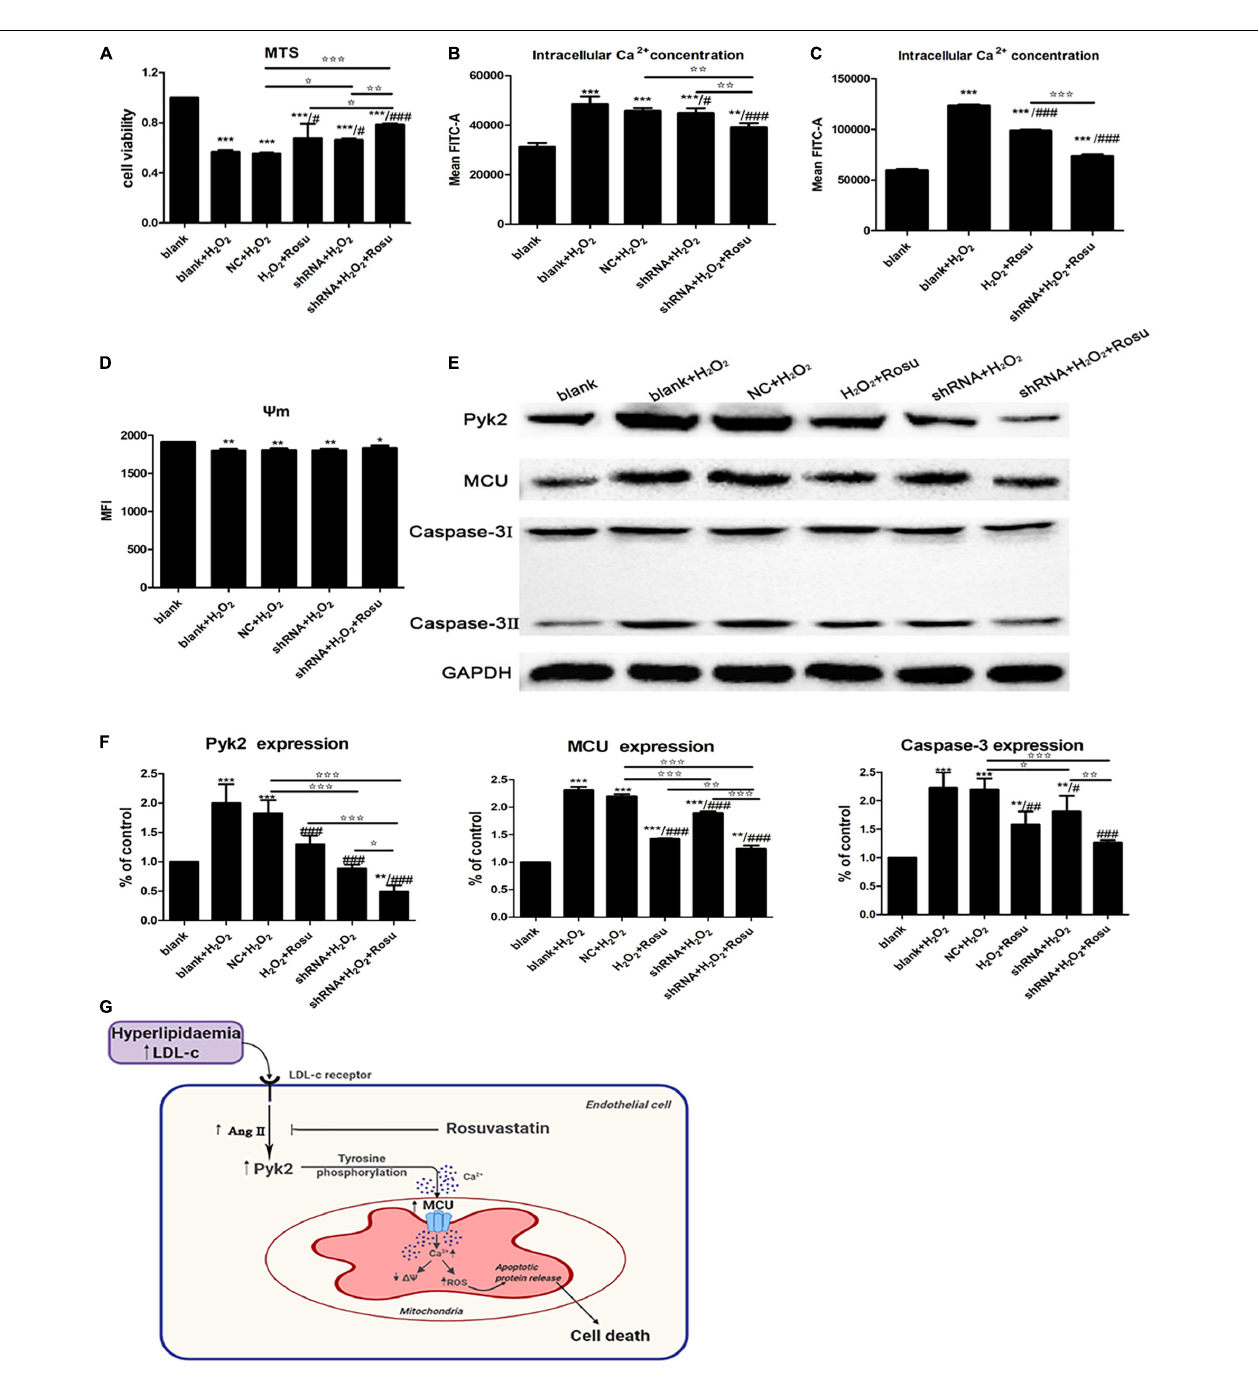
FIGURE 8 | The effect of Pyk2 down-regulation on H 2 O 2 -induced human umbilical vein endothelial cells (HUVECs) injury and regulation of the Pyk2/mitochondrial calcium uniporter (MCU) pathway in endothelial cell. (A) Detection of cell viability by 3-(4,5-dimethylthiazol-2-yl)-5-(3-carboxymethoxyphenyl)-2-(4-sulfophenyl)- 2H-tetrazolium assay after transfection with shRNA. (B–D) Detection of intracellular free Ca 2 + and mitochondrial membrane potential in different groups by flow cytometry. (E) Pyk2, MCU, and caspase-3 protein expression in different groups by western blot. (F) Statistical graph of panel (E) . Data are shown as mean ± SD of at least three independent experiments. * P < 0.05, ** P < 0.01, *** P < 0.001 versus vehicle blank group (control); # P < 0.05, ## P < 0.01, ### P < 0.001 versus vehicle H 2 O 2 group (blank+H 2 O 2 ); (cid:73) P < 0.05, (cid:73)(cid:73) P < 0.01, (cid:73)(cid:73)(cid:73) P < 0.001, NC+H 2 O 2 vs. shRNA+H 2 O 2 , NC+H 2 O 2 vs. shRNA+H 2 O 2 +Rosu; H 2 O 2 +Rosu vs. shRNA+H 2 O 2 +Rosu, shRNA+H 2 O 2 vs. shRNA+H 2 O 2 +Rosu, one-way ANOVA. (G) Endothelial angiotensin II involvement-Pyk2-dependent MCU phosphorylation initiates mitochondrial Ca 2 + entry, which, in turn, induces reactive oxygen species generation and a decrease in mitochondrial membrane potential (MMP/ (cid:49)(cid:57) ) and eventually leading to cell